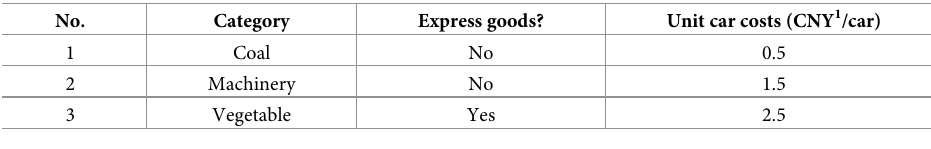
Table 5. Goods categories and unit car costs.